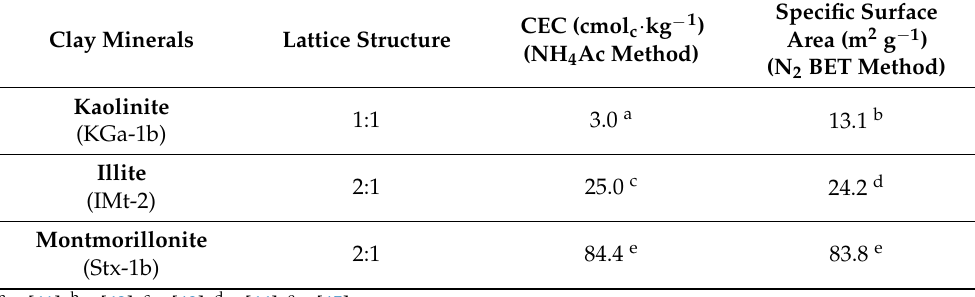
Table 2. Selected properties of clay minerals used in the study. Clay Minerals